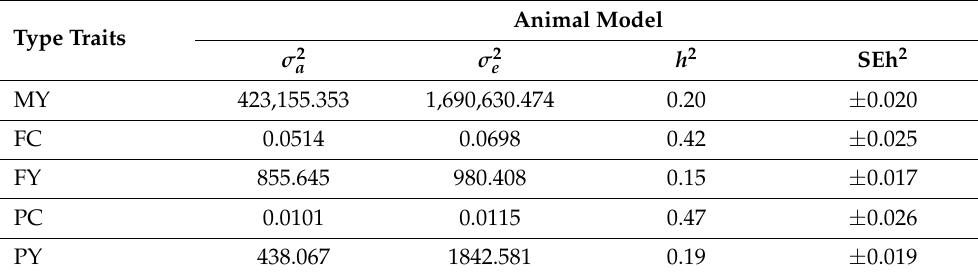
Table 2. Estimates for the additive genetic variance ( σ 2 a ), heritability ( h 2 ), and standard error (SEh 2 ) for milk